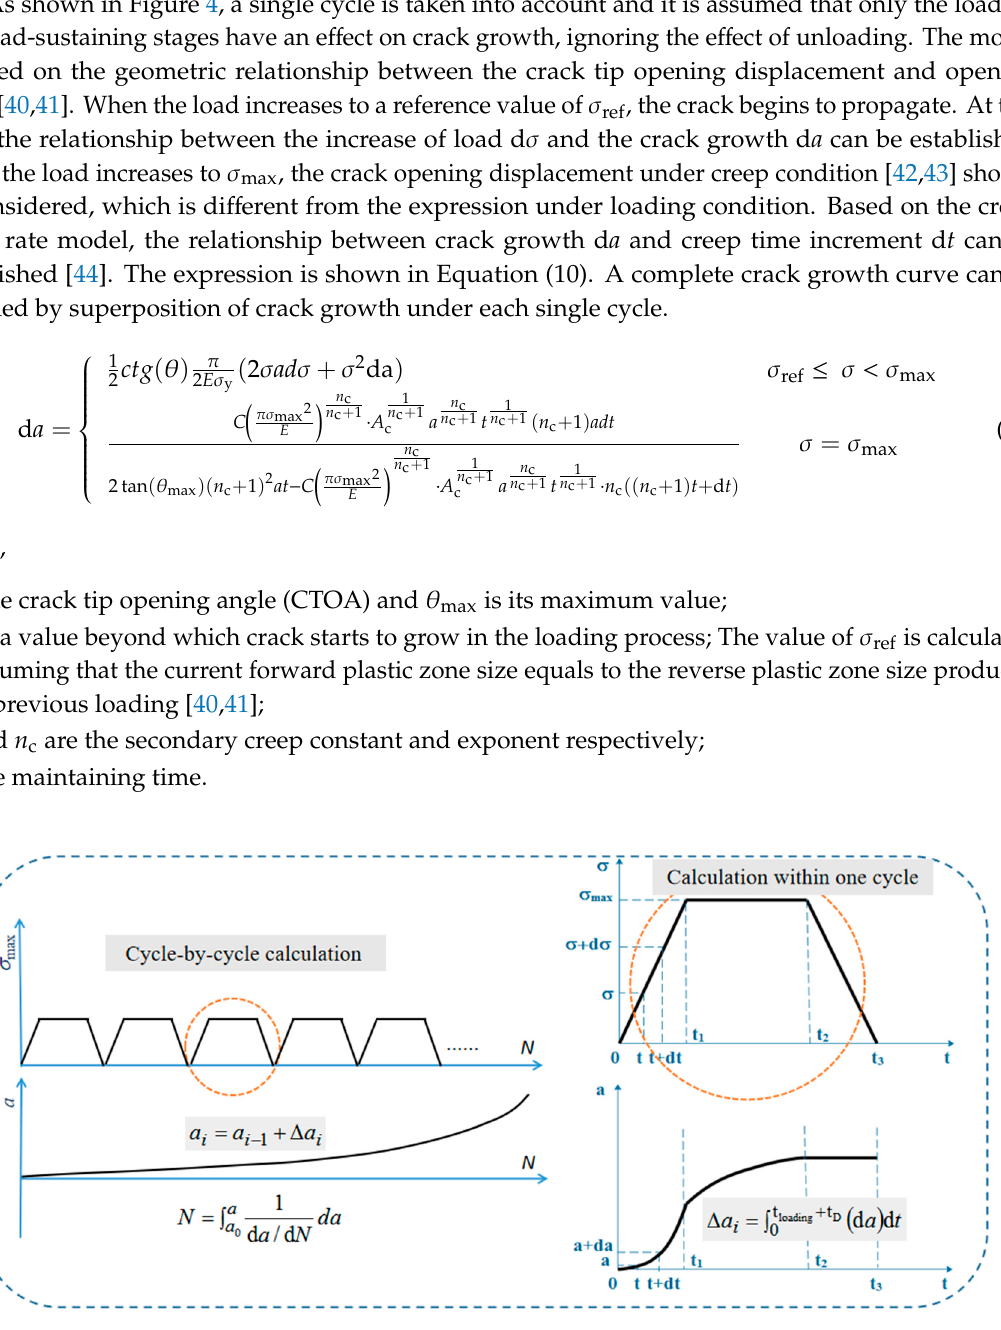
Figure 4. Correlation between cycle-by-cycle calculation and calculation within one cycle.